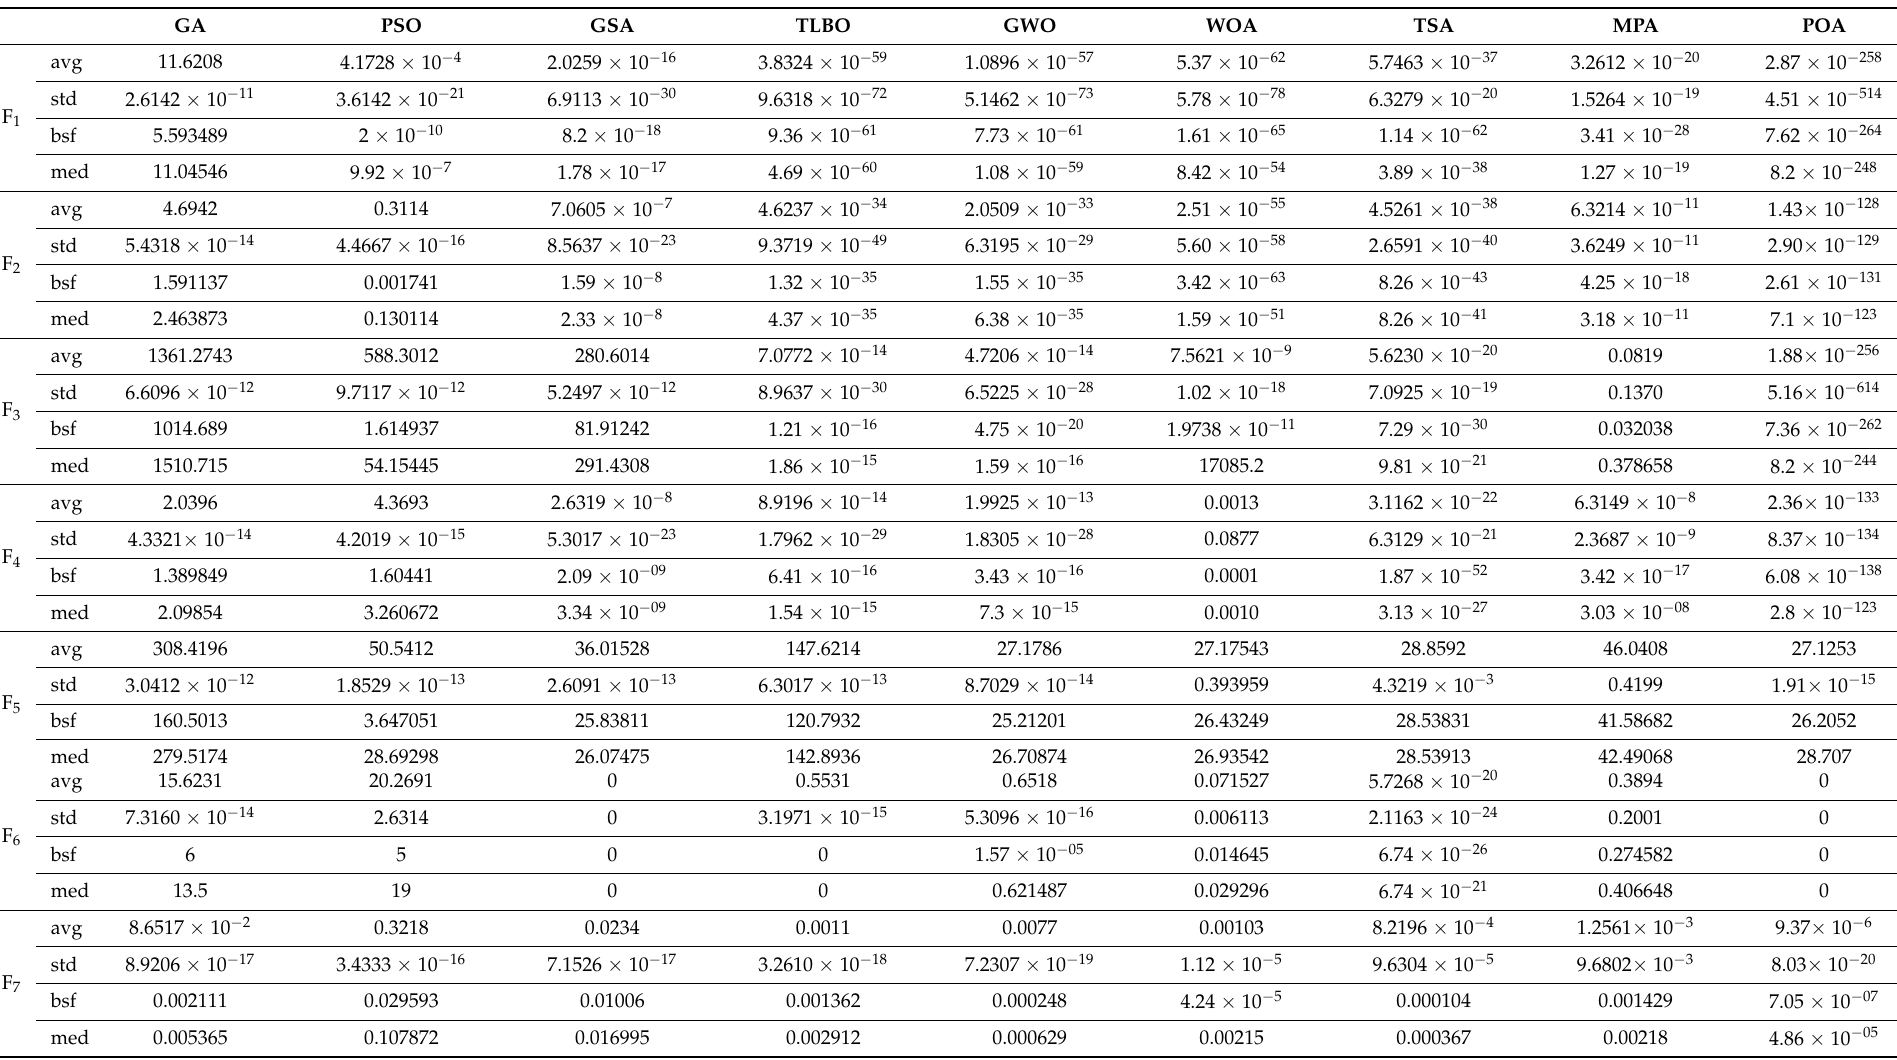
Table 2. Evaluation results of unimodal